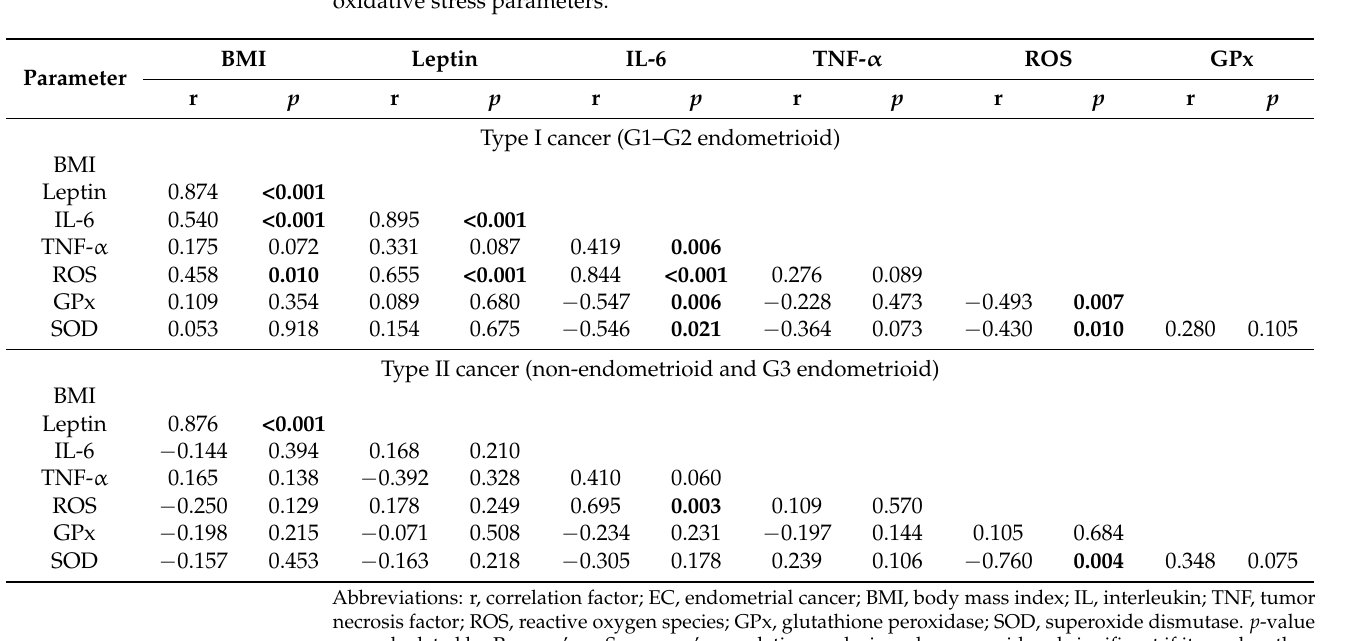
Table 6. Cross-sectional interrelationship between BMI, leptin, proinflammatory cytokines, and oxidative stress parameters.